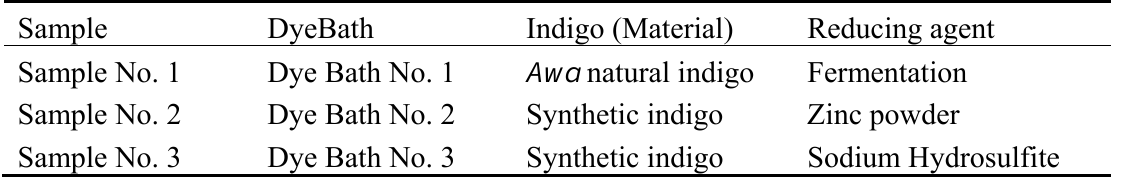
Table 1. Samples and dye